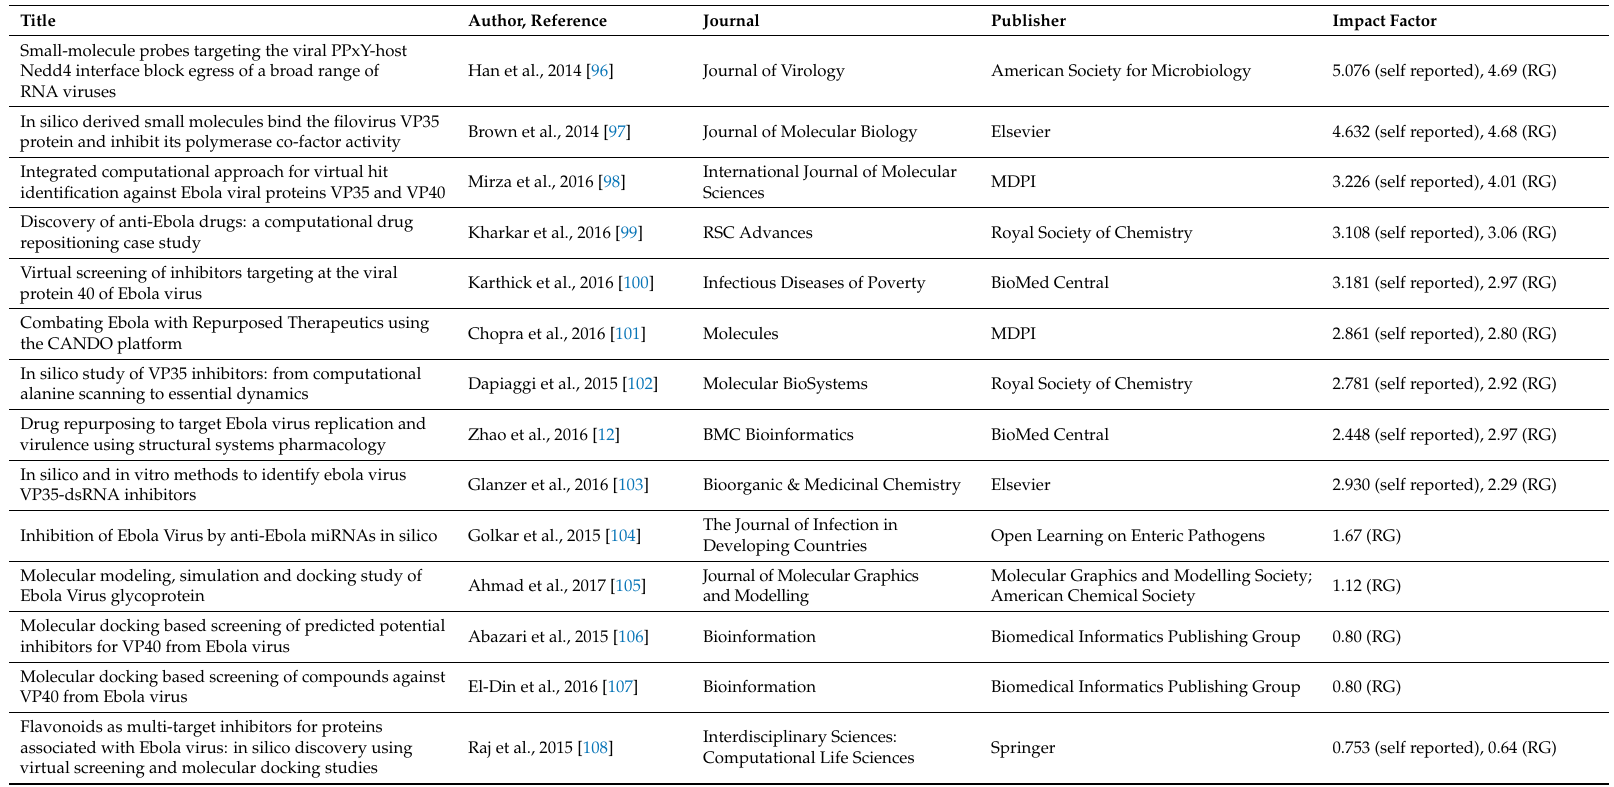
Table 1. List of the publications reviewed. For each publication, the title, author and year of publication, the journal in which it was published, the publisher, and the impact factor of the journal are given. While not the most ideal criterion, the publications are listed in order of decreasing impact factor, self reported or as reported by ResearchGate (RG) [95] (NA = not available; NF = not found). When two impact factors are reported, the lower of the two is used. Research articles without corresponding impact factors are listed at the end. This ordering is used in subsequent tables. The quality of the studies is variable, and thus their contribution to the endeavor of finding treatments for EVD may be as